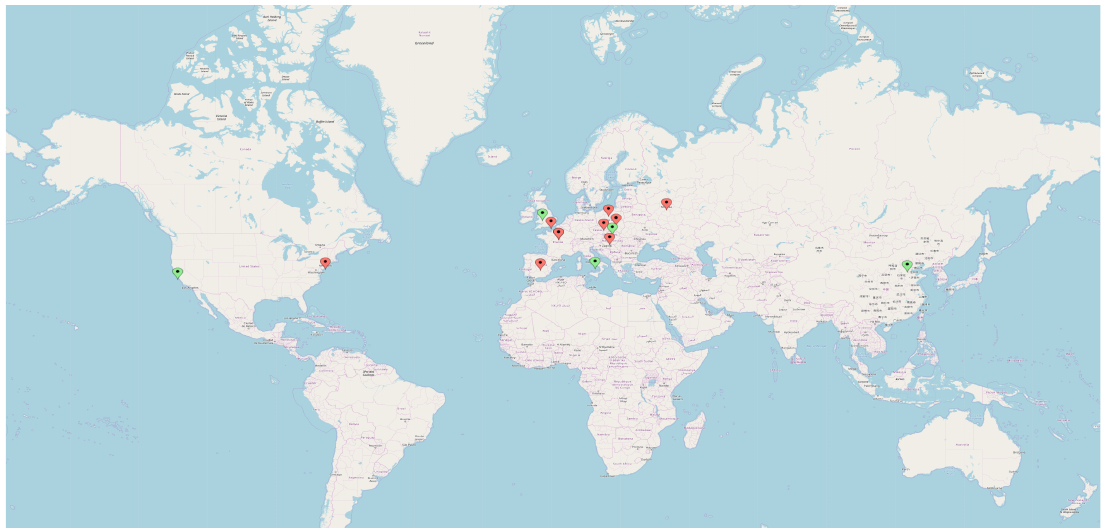
Figure 3. Cities used for training (red markers) and verifying (green markers) datasets.